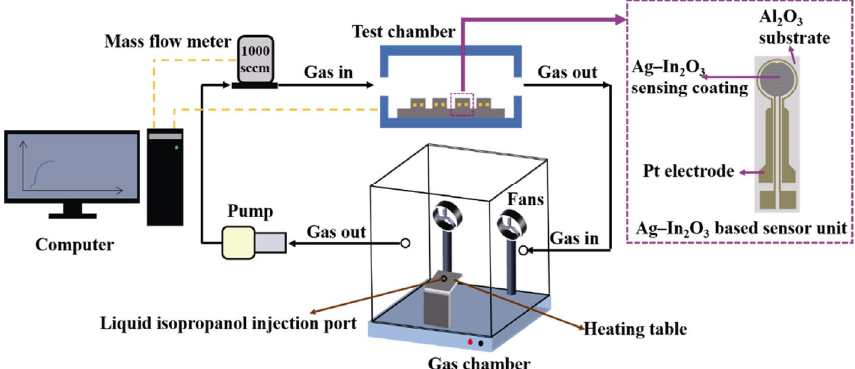
Fig. 2 Details of the gas sensing testing